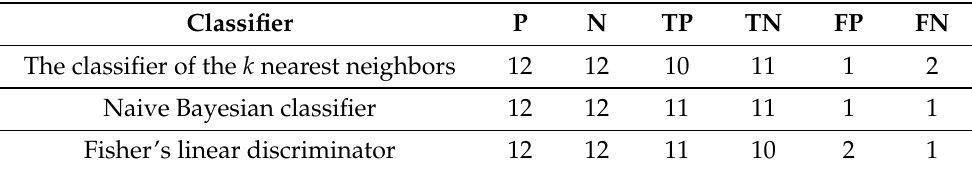
Figure 13. Decision surfaces of each classifier. Table 4. Classification